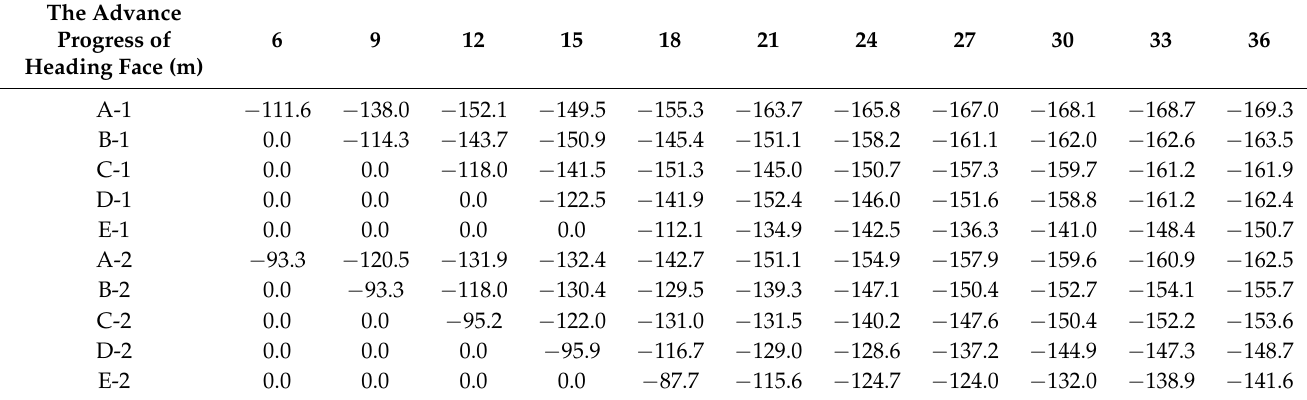
Table 14. Axial force trend of the second-layer steel support (Unit: kN).